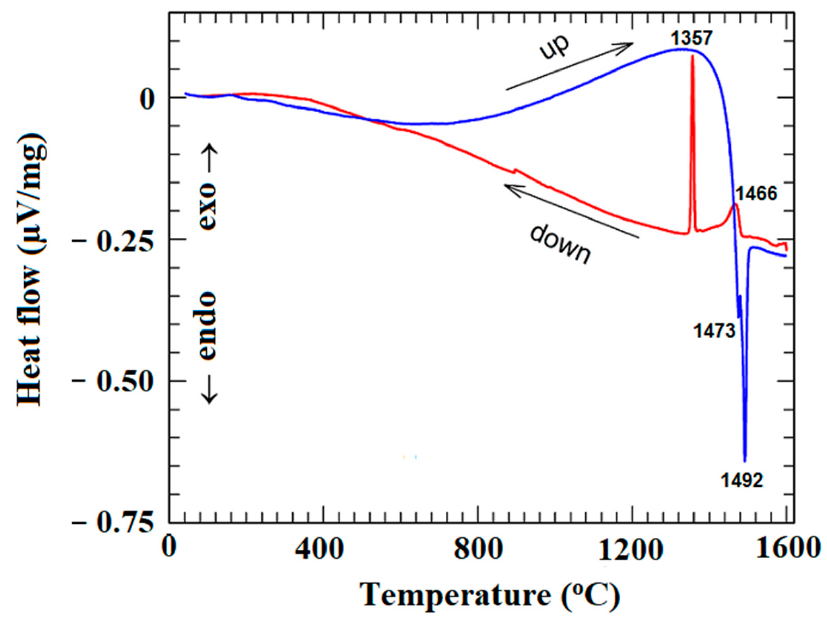
Figure 2. DTA analysis of La 0.765 Y 0.485 Sc 2.75 (BO 3 ) 4 nonstoichiometric compound. (Reprinted with permission from ref. [13], copyright 2019 American Chemical Society).